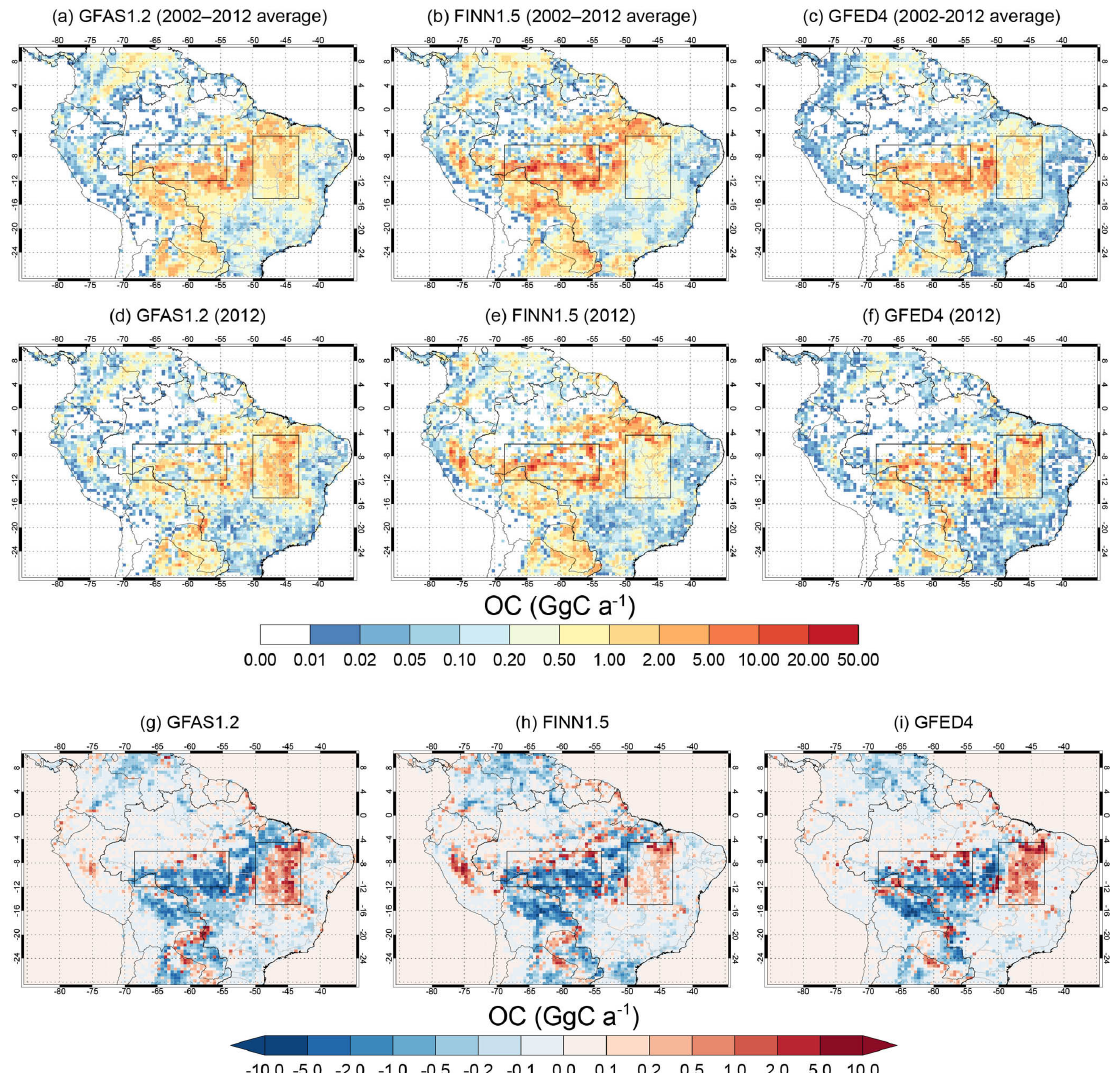
Figure 1. Maps of estimated total annual organic carbon (OC) aerosol emissions from fire, shown as (a) – (c) an average for the period 2002 to 2012 and (d) – (f) for 2012. The difference in OC emissions between 2012 and 2002 to 2012 (2012 emissions minus the 2002–2012 average) is shown in (g) – (i) . Blue colours show where emissions in 2012 were lower than in 2002 to 2012, while red colours show where emissions were greater. Emissions are shown for GFAS version 1.0 (2002–2011) and version 1.2 (2012) (a, d) , FINN version 1.5 (b, e) , and GFED version 4 (c, f) . The GFAS, FINN and GFED OC emissions were re-gridded onto a common grid of 0 . 5 ◦ × 0 . 5 ◦ resolution for comparison. The black boxes show the eastern (4.5–15 ◦ S, 43–50 ◦ W) and western (6–12 ◦ S, 54–68.5 ◦ W) domains (see Fig.